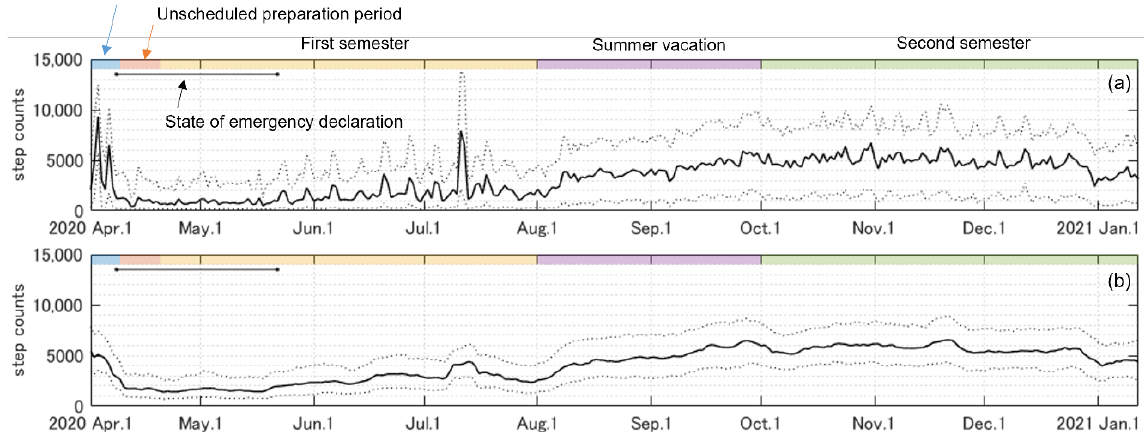
Figure 2. Time-series changes in the median daily step counts. ( a ) Median daily step counts (solid line) with 25% and 75% quantiles (dotted line) across 603 participants; ( b ) the 7-day moving average daily step counts (solid line) with 25% and 75% quantiles (dotted line).